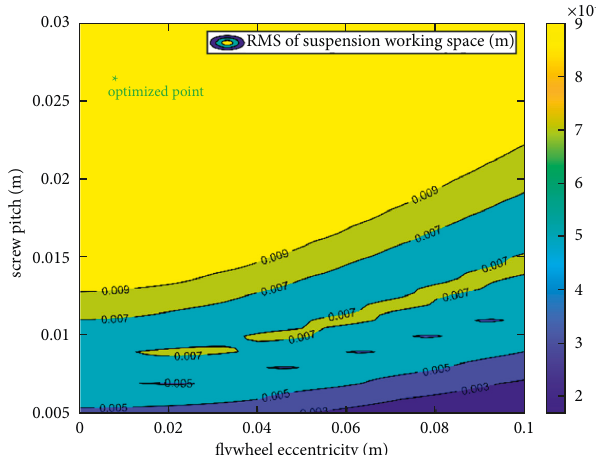
Figure 15: The change of suspension working space subject to the change of flywheel and screw pitch in the parallel model.